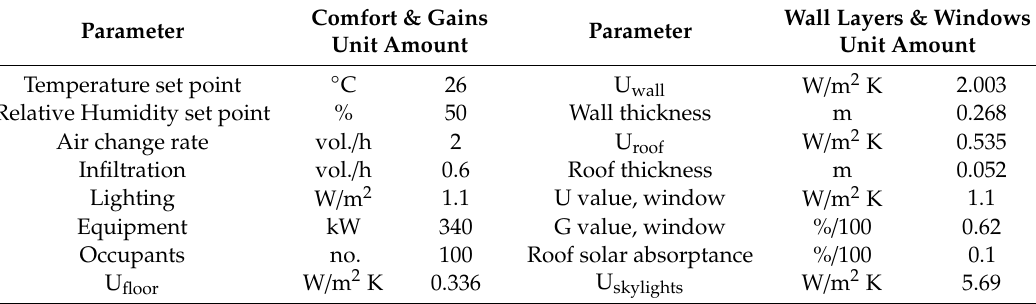
Figure 4. Water-cooled vapour compression cooling system simulated in TRNSYS. Table 1. Building envelop characteristics and design cooling load